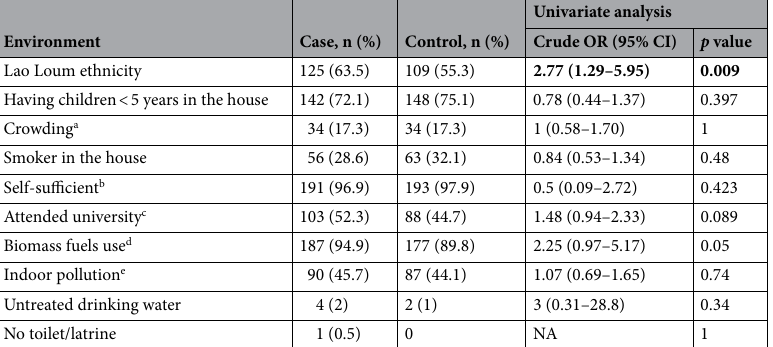
Table 3. Environmental factors associated with ARI. Significant values are in bold. a More than 7 people living in the same house. b The income of the family is sufficient to live on judged by family. c Highest form of education in the family. d Charcoal or wood were used in cooking. e Making fire inside the